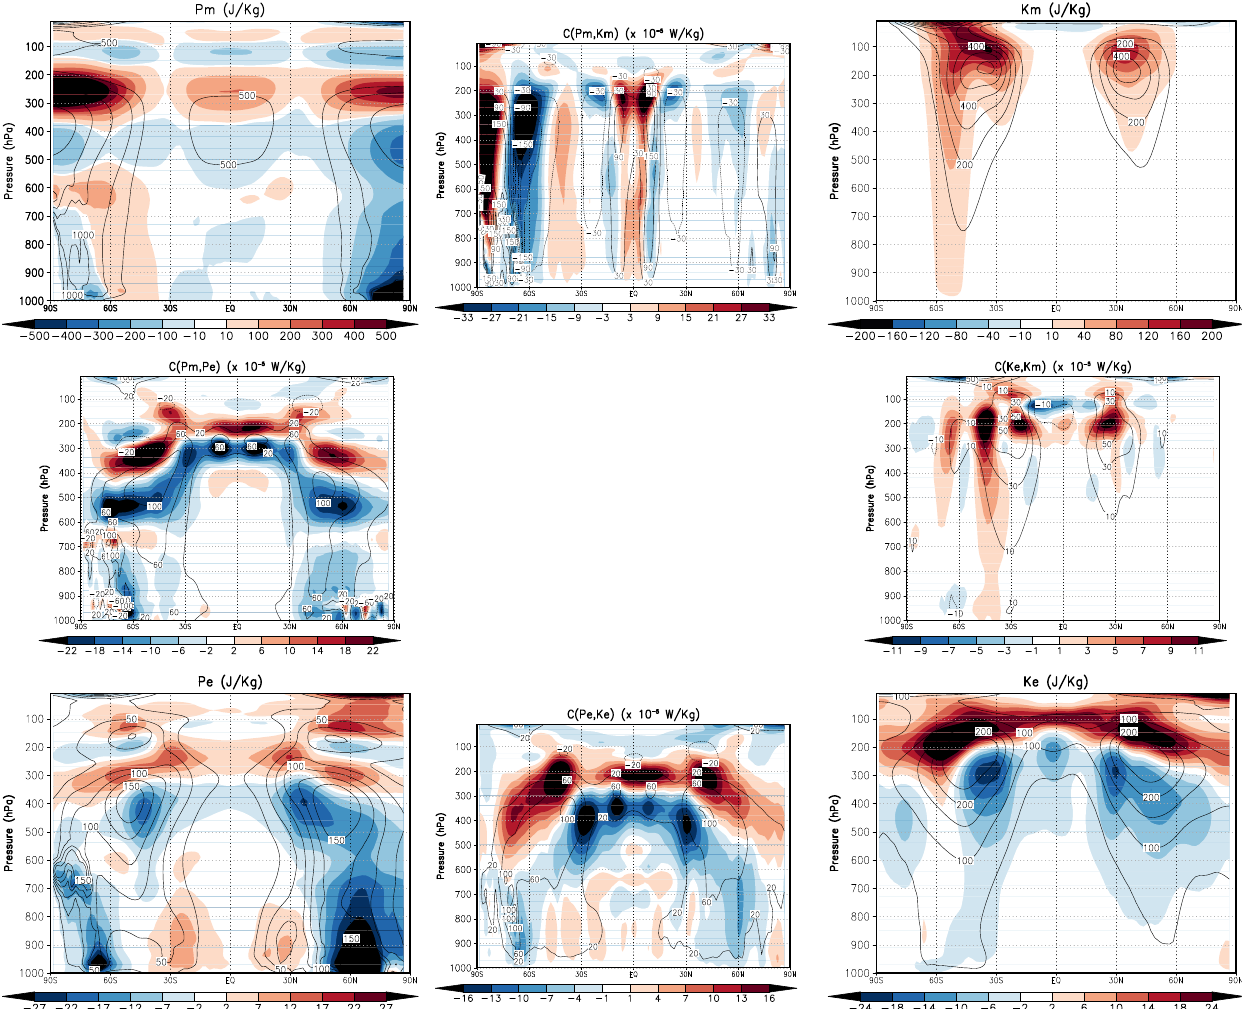
Fig. 3. Vertical cross-sections of the 4-box LEC terms for the 1 × CO 2 control experiment (contours), and their change in the 2 × CO 2 experiment (color shaded). Counterclockwise, starting from the upper left: P m , C(P m , P e ) , P e , C(P e , K e ) , K e , C(K e , K m ) , K m , and C(P m , K m ) . Units are Jkg − 1 for reservoirs, and 10 − 5 Wkg − 1 for conversion